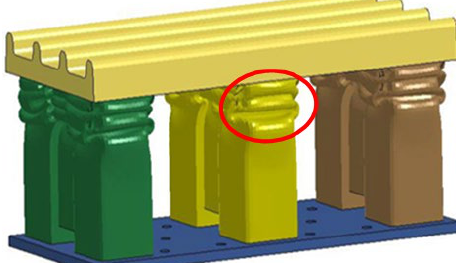
Figure 10. Anti-creep deformation process